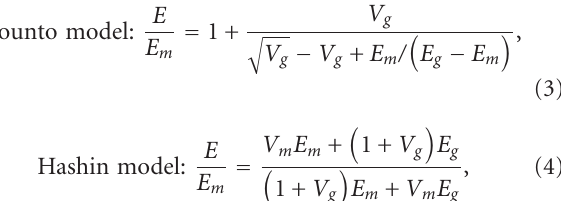
Figure 7: Comparison of inside strain and surface